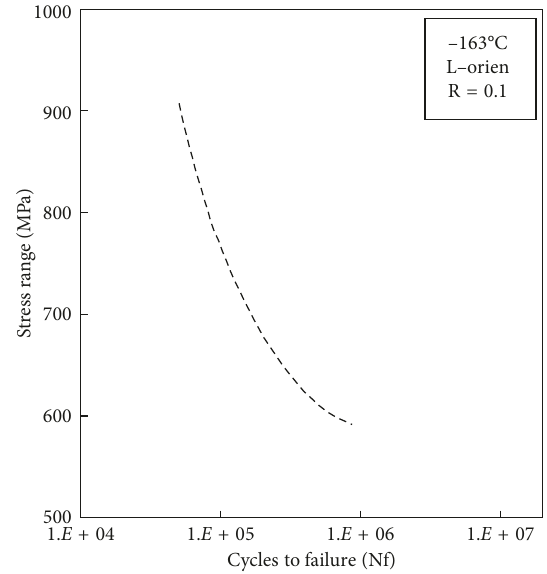
Figure 14: S-N curve for 304 stainless steel under cryogenic